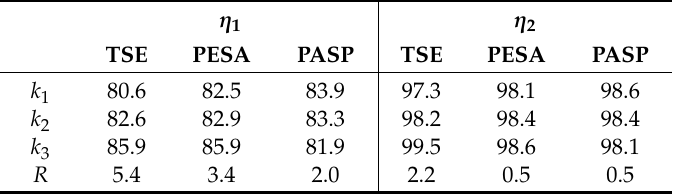
Table 3. The analysis of orthogonal test